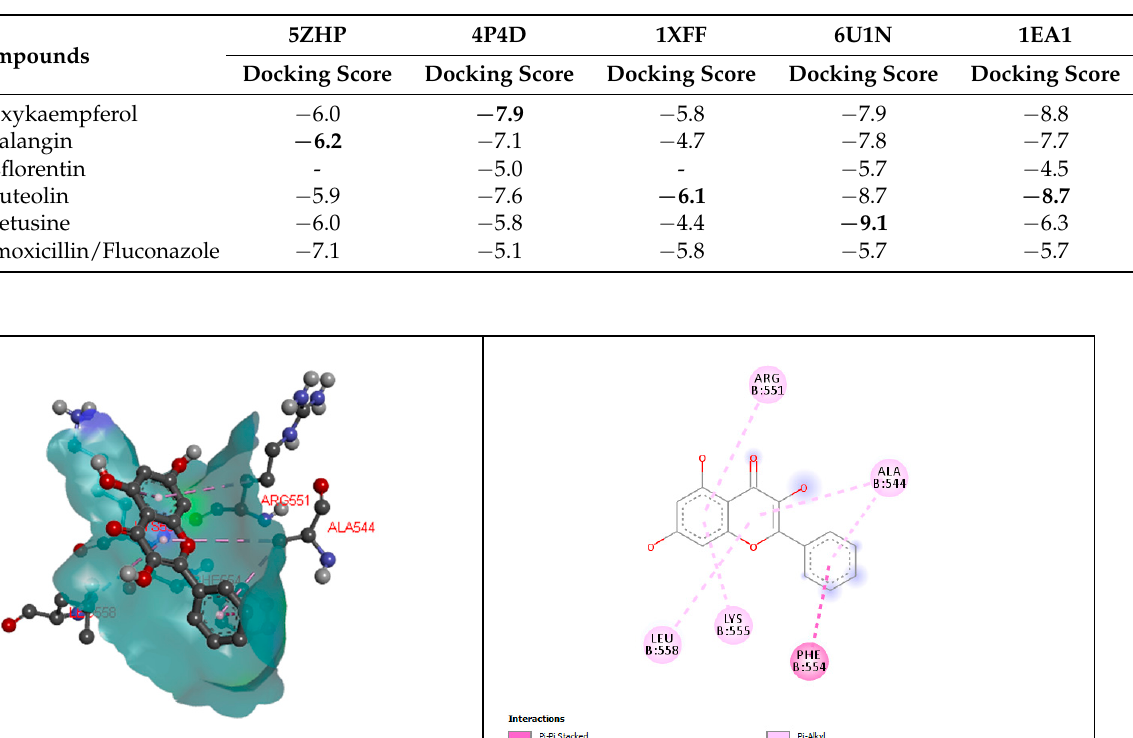
Table 7. Docking score of 6-Hydroxykaempferol, Galangin, Irisflorentin, Luteolin, Retusine, and